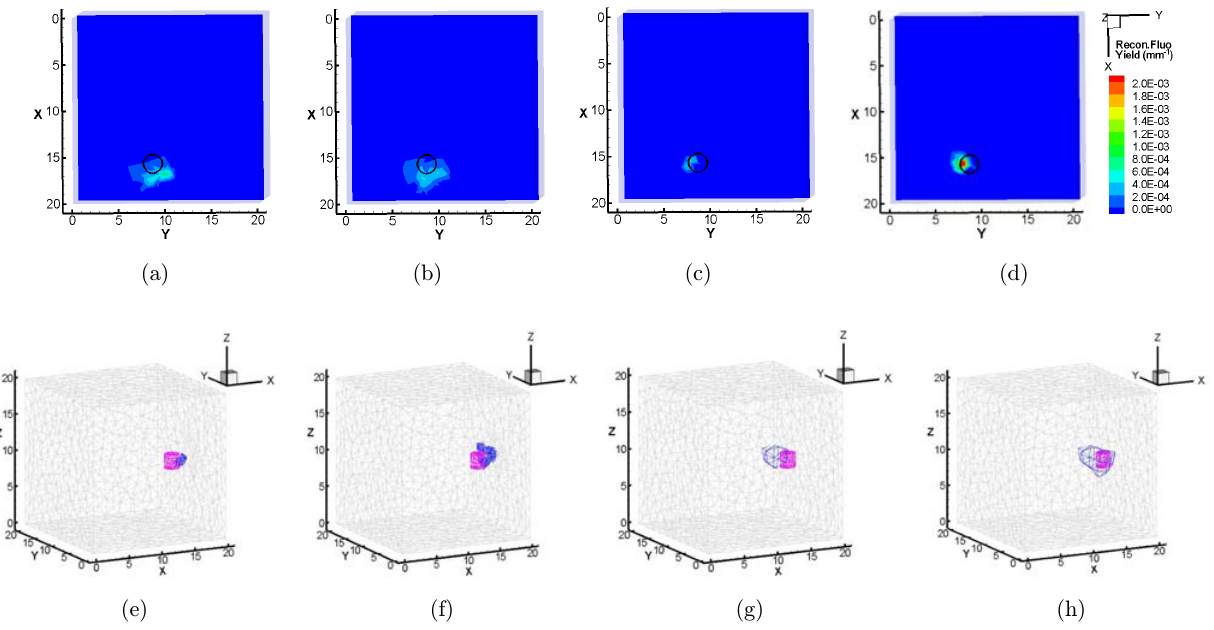
Fig. 7. Reconstructed results of phantom data. (a) – (d) are the transverse views of the reconstruction by OMP, StOMP, ROMP and CoSaMP on the plane of z ¼ 9 : 5 mm. The black circle in transverse view represents the true target. (e) – (h) are the 3D isosurface views of the results with top 80 % of the maximum value, where the red cylinder represents the true position of Cy5.5 solution and the blue zone is the reconstructed target.